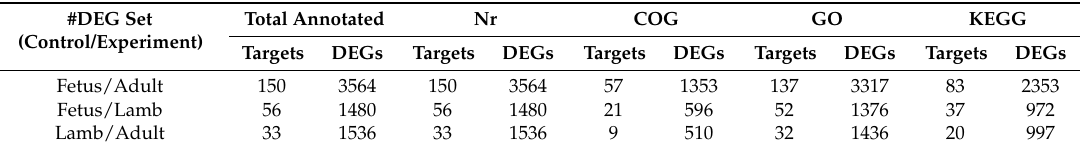
Table 2. The functional annotation of the target genes of the differentially expressed lncRNAs (targets) and differentially expressed genes (DEGs) using non-redundant protein sequence database (Nr), Clusters of Orthologous Groups of proteins (COG), Gene Ontology (GO) and Kyoto Encyclopedia of Genes and Genomes (KEGG)